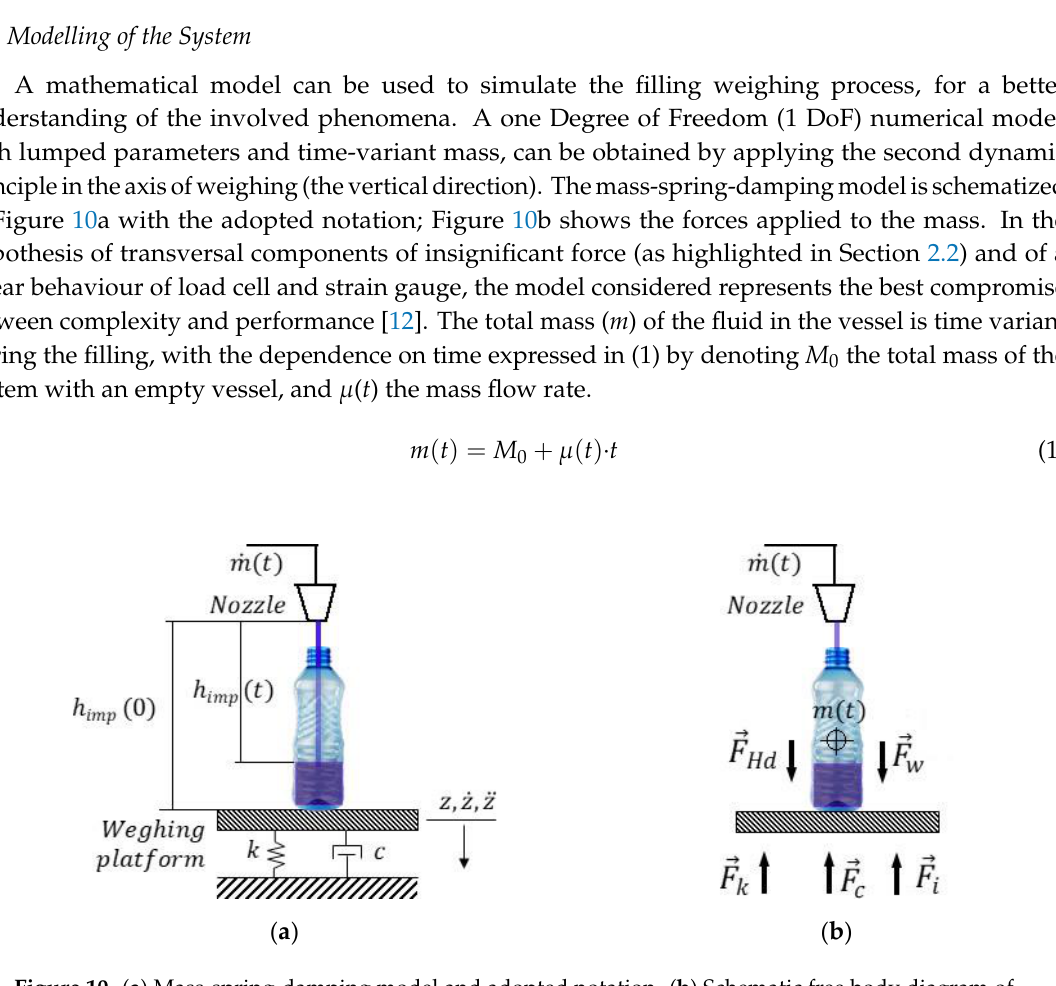
Figure 10. ( a ) Mass-spring-damping model and adopted notation. ( b ) Schematic free body diagram of mass m(t).